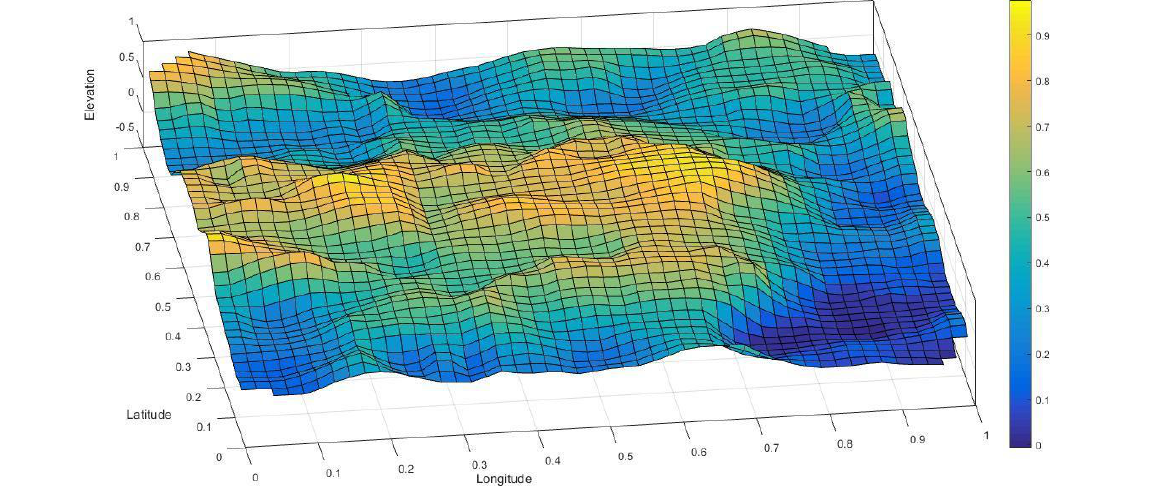
Figure 6. 3D terrain modelling from elevation data using homotopy continuation based on piecewise cubic spline interpolation.